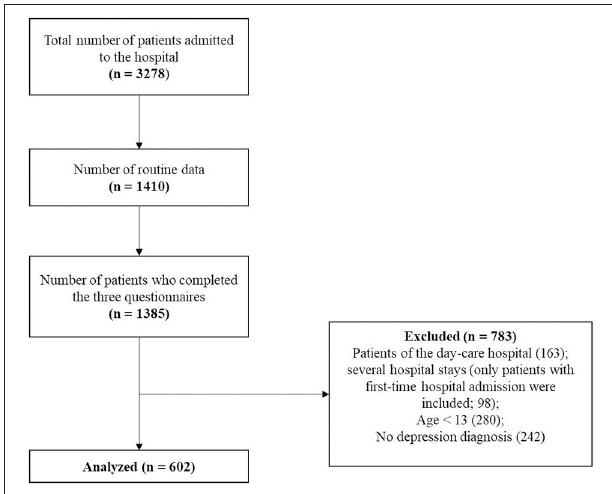
FIGURE 2 | Patient